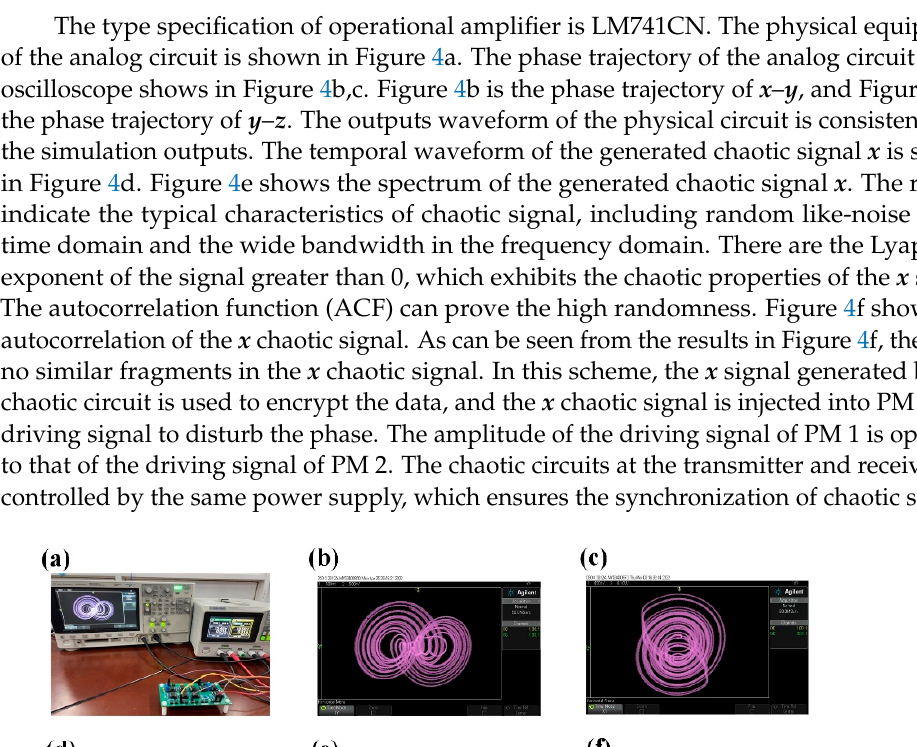
Figure 3. Chaotic circuit schematic diagram.